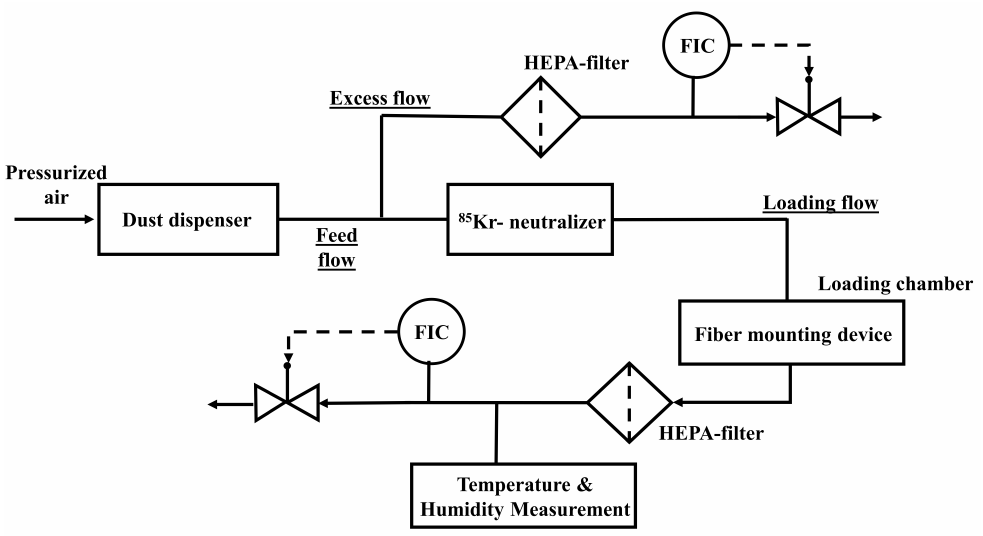
Figure 2. Schematic setup to produce an aerosol containing glass spheres and the deposition on a single fibre that is clamped at the fiber mounting device